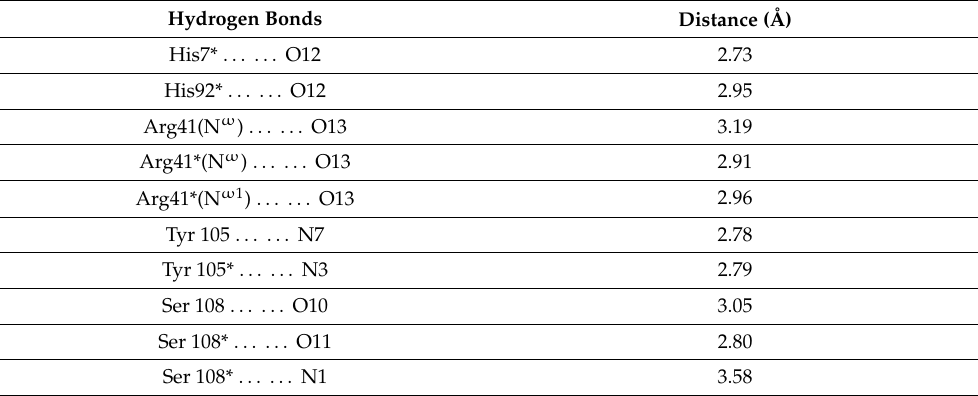
Figure 5. The geometry structure of 1a , some important bond lengths are labeled in the unit of Å. Table 2. The hydrogen bond lengths (Å) between kp HIUH and the substrate 5-HIU in the optimized complex 2 . The distances are measured between the two heavy atoms in the hydrogen